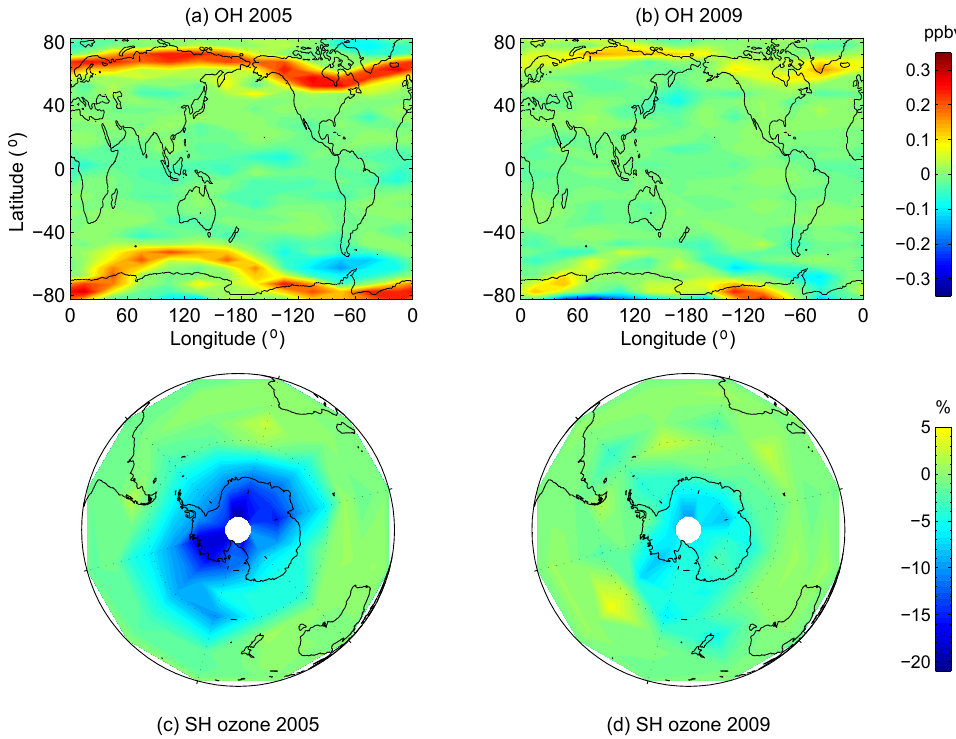
Figure 15. (a, b) Difference in yearly median OH mixing ratios at about 70–80km between SD-WACCM runs with and without MEE ionization. (c, d) Relative differences in southern hemispheric wintertime mean O 3 at about 70–80km between SD-WACCM runs with and without MEE